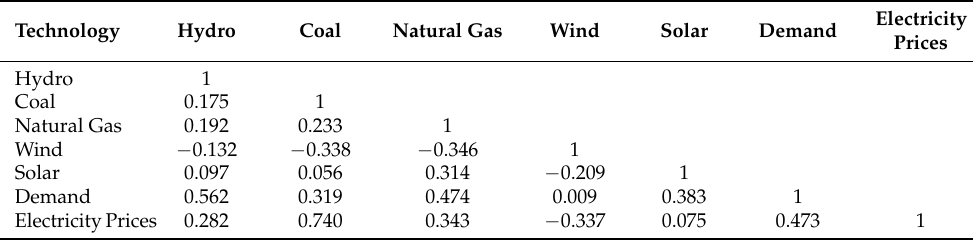
Table 6. Hourly correlation between generation technologies, demand, and MIBEL prices (2015–2019) for Portugal only.